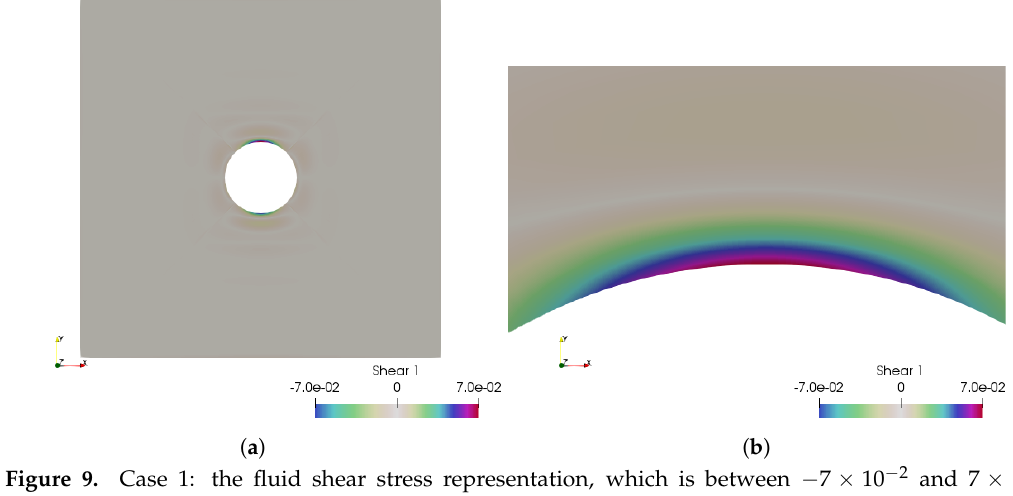
Figure 9. Case 1: the fluid shear stress representation, which is between − 7 × 10 − 2 and 7 × 10 − 2 dyn/cm 2 . ( a ) The fluid shear stress overview; ( b ) zoom over the higher shear stress zone.